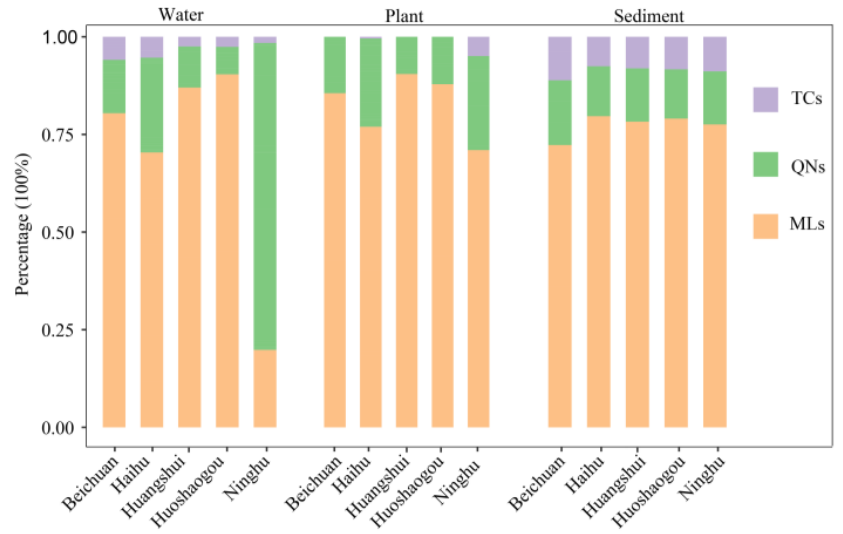
Figure 2. The concentrations of antibiotics in water samples, plant samples, and sediment samples. In the water samples, the distribution of antibiotics was the highest in the Ninghu wetland (Figure 3a), with the main components being OFX, NFX, and AZM. Moreover, DOX and RTM were detected only in the Ninghu wetland. The most distributed antibiotic in the Beichuan wetland, Huoshaogou wetland, and Huangshui River was AZM. AZM was the most distributed in the Haihu wetland, followed by NFX, OFX, and ERM. AZM was the most widely distributed in the wetlands (Figure 3b). QNs and MLs were the most distributed in the Haihu wetland, while TCs were distributed only in Haihu and Ninghu wetlands. AZM and TYL were mostly detected in the Huangshui River, the Huoshaogou wetland, and the Beichuan wetland (Figure 3c). RTM, ERM, and TYL were mostly distributed in the Beichuan wetland and Haihu wetland. TYL was not detected in the Huangshui River and Ninghu wetland, and OTC was detected only in the Huangshui